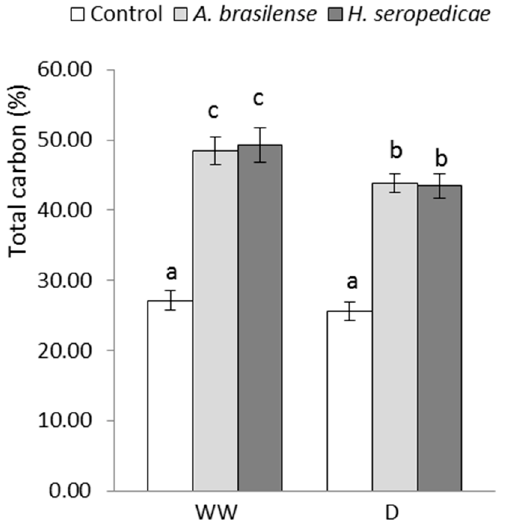
Figure 2. Percentage of total carbon content 20 DAS. Data are shown as means ± SD ( n = 3). Means with common letters are not significantly different ( p > 0.05). The plants were cultivated under WW or D conditions. The inoculation * drought interaction p = 0.0473.